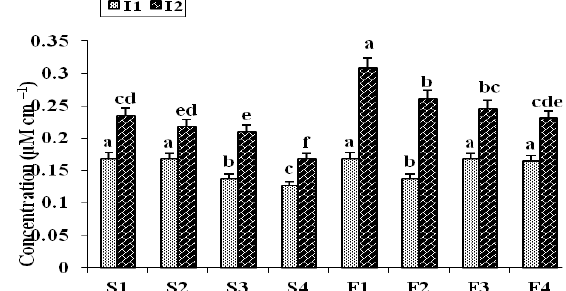
Fig. 7. Changes in proline content due to water deficit stress and application of Fe; I1- normal irrigation or irrigation to reach 50% soil moisture depletion of field capacity, I2- irrigation from the beginning of flowering to the end of pollination stage reaching 75% of soil moisture depletion of field capacity; S- soil application of Fe, S application of Fe; S2- 50 Fe Kg ha -1 , S3- 100 Fe Kg ha ha -1 ; F- foliar application of Fe, F1- foliar application of water, F2 Fe mg l -1 , F3- 2,000 Fe mg l -1 , F4- 3,000 Fe mg l each column of each section followed by the same letter are not significantly different (p ≤ 0.05)